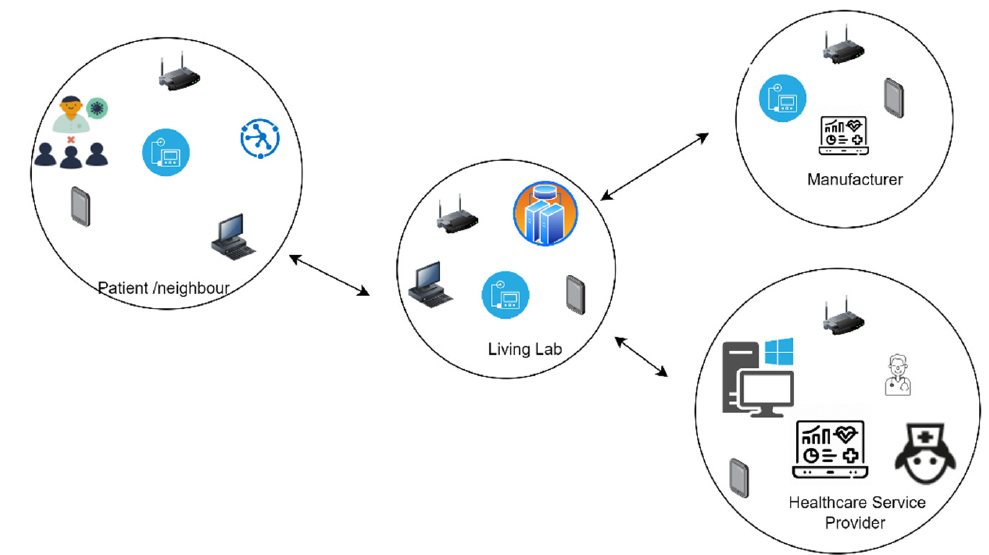
Figure 4. Living lab healthcare scenario.